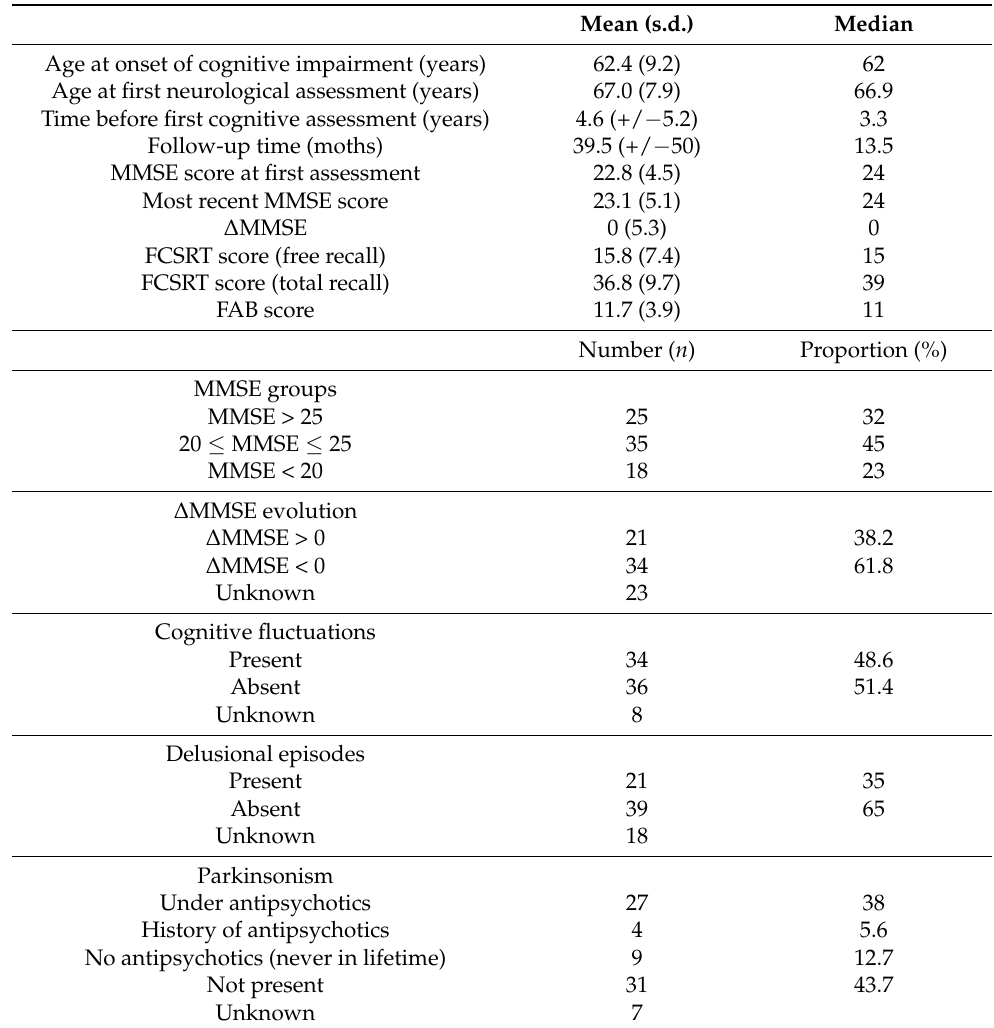
Table 3. Neurocognitive